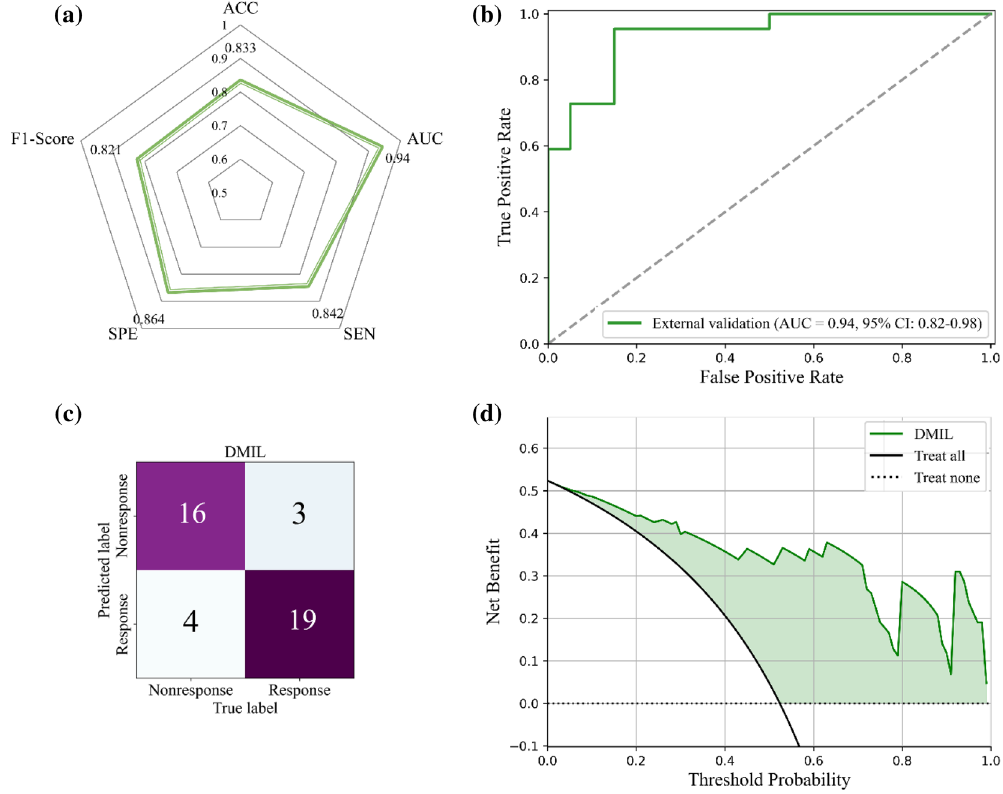
Figure 7. Performance of the DMIL model in the external validation. ( a ) Statistical results; ( b ) The ROC curve; ( c ) The confusion matrix; ( d ) The DCA